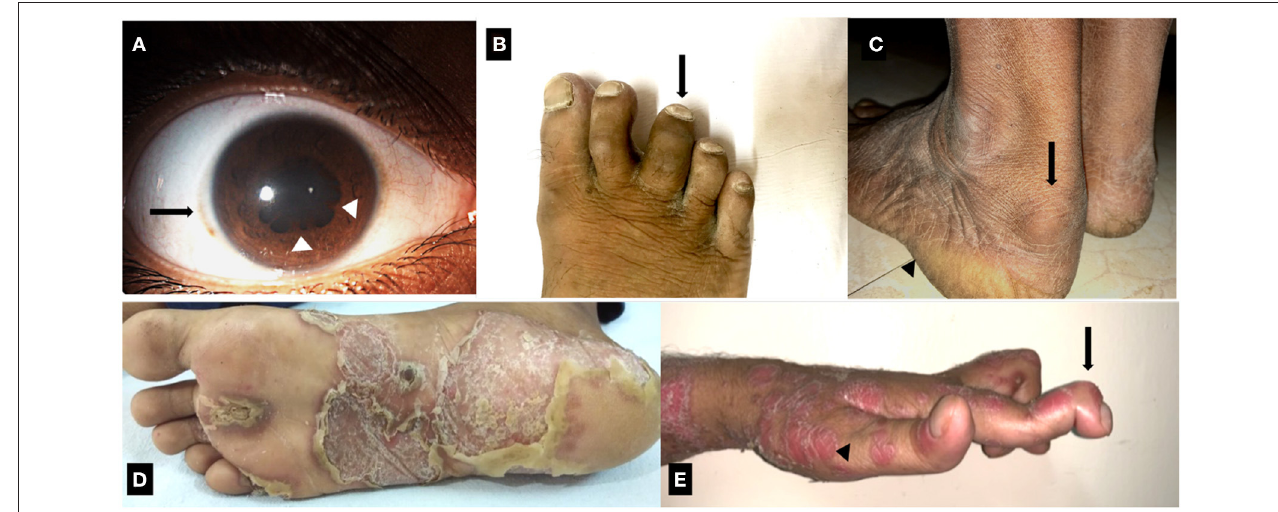
FIGURE 1 | Clinical manifestations of Spondyloarthritis. (A) Resolving recurrent acute anterior uveitis of right eye in a case of ankylosing spondylitis. Solid arrow: mild circum-corneal congestion. Arrowhead: posterior synechiae. (B) Dactylitis of third toe of the right foot in a case of Psoriatic arthritis. (C) Enthesitis involving the Achilles tendon in a case of ankylosing spondylitis. Solid arrow: retrocalcaneal bursitis, which co-occurs with Achilles enthesitis. Arrowhead: site of plantar fasciitis. (D) Keratoderma blennorrhagica involving the sole of a patient with Reactive arthritis. (E) Psoriasis (arrowhead) with deforming peripheral arthritis of hand joints. Solid arrow: arthritis and deformity of distal interphalangeal